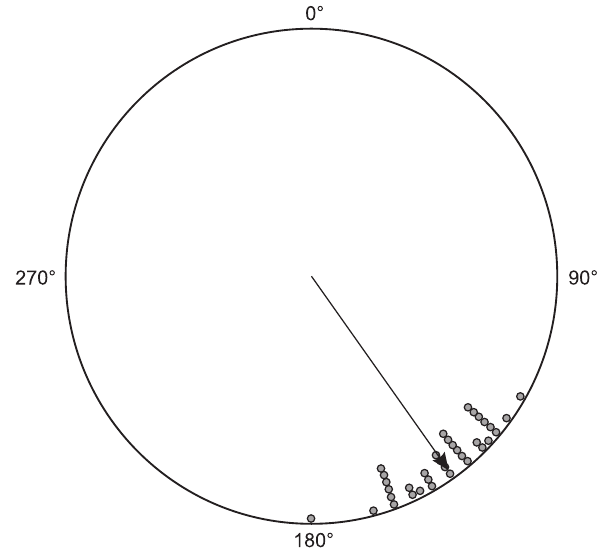
Figure 3. Cardinal orientations of Mabuya macrorhyncha individuals (N = 35, in degrees) at first sight on different circular-shaped sub- strates (mainly bromeliads) in the Restinga of Grussaí, municipality of São João da Barra, state of Rio de Janeiro, southeastern Brazil. The arrow direction represents the mean vector (µ), and its length represents the length of the mean vector ( r